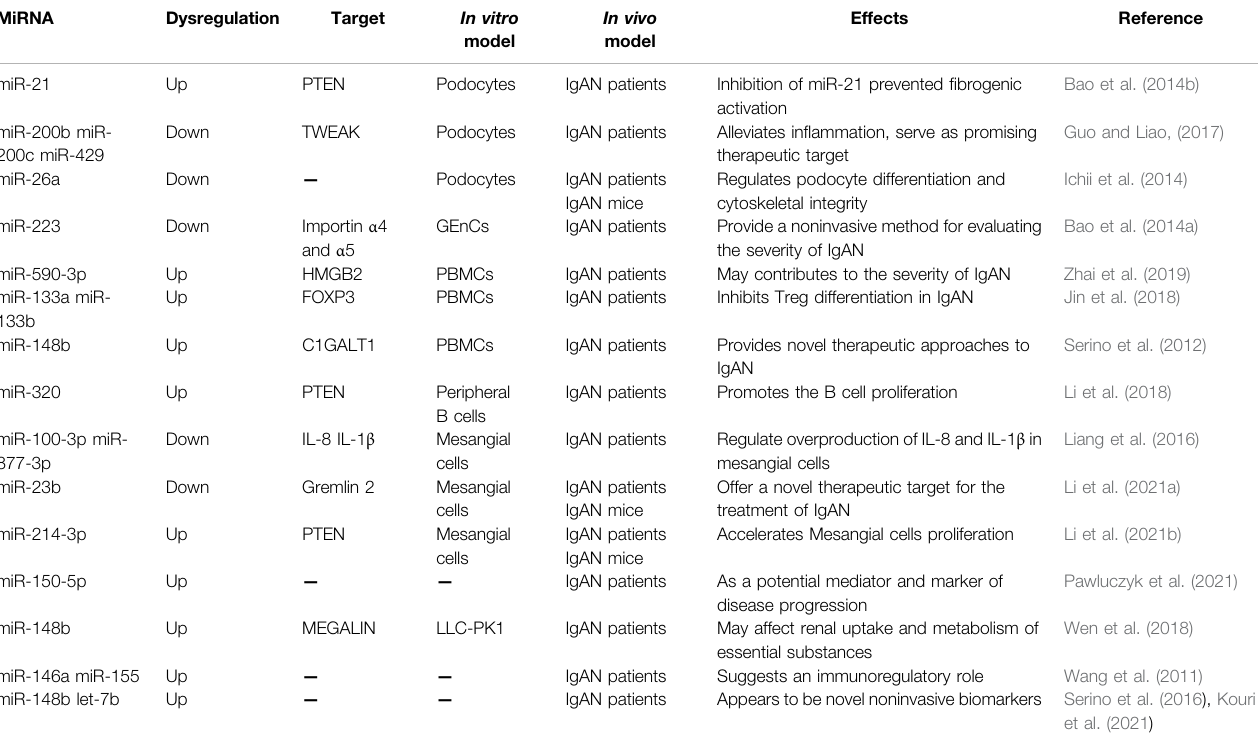
TABLE 5 | MiRNAs in IgA nephropathy.